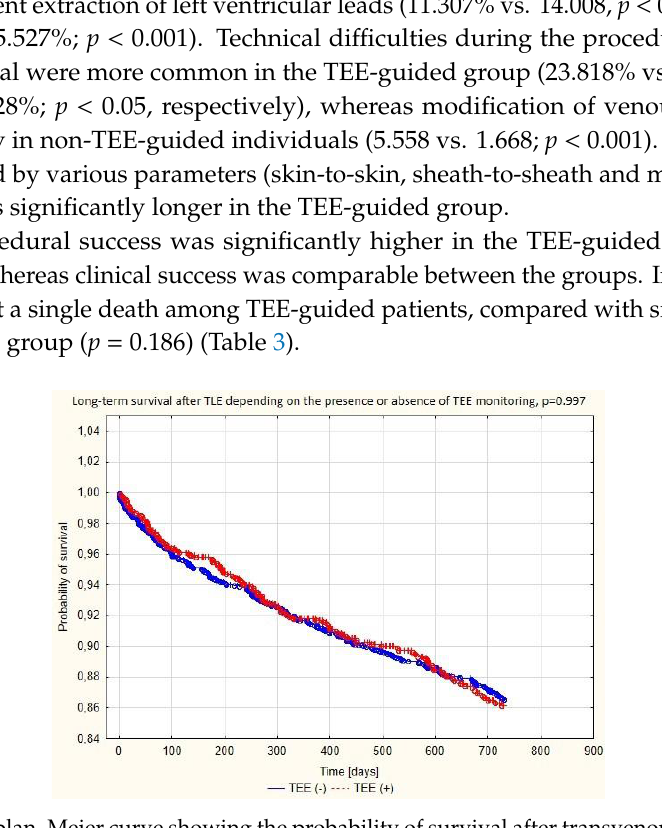
Figure 1. The Kaplan–Meier curve showing the probability of survival after transvenous lead extraction (TLE) in patients with and without transesophageal echocardiography (TEE) monitoring. Table 3. Data on TLE